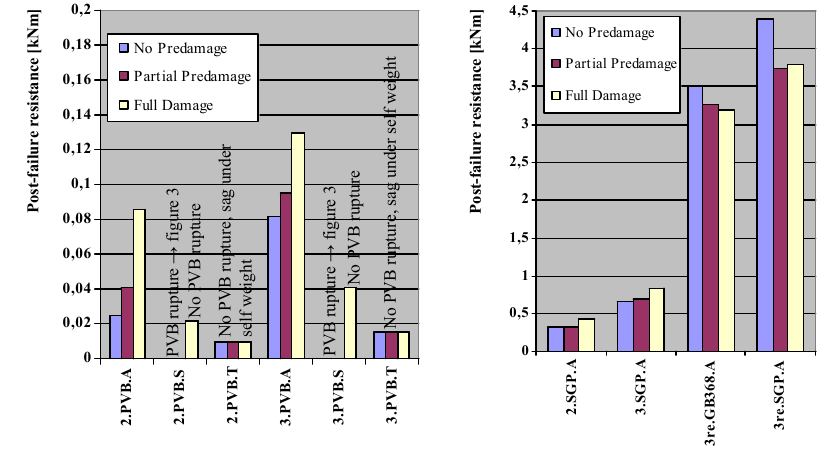
Figure 1: Dependency of maximum post-failure resistance of different glass beam designs on the level of predamage applied. No predamage causes high energy release, full damage causes low energy